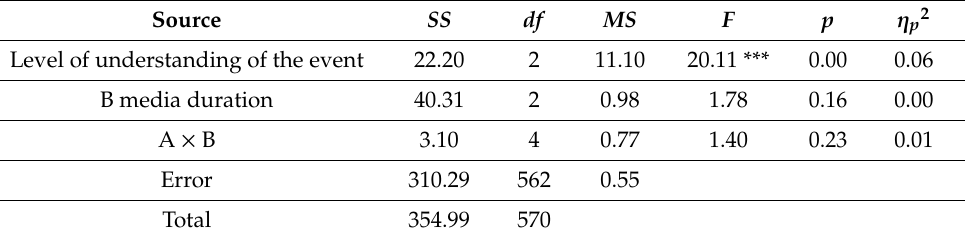
Table 6. Variance analysis of the level of events understanding and the media duration on WOM. Source SS df MS